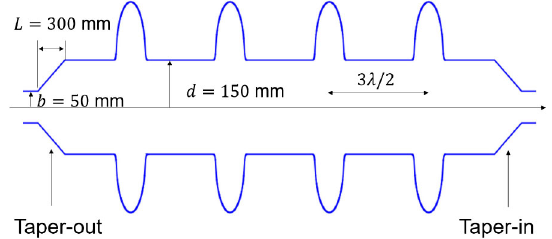
FIG. 3. Example of the LHC-like cryomodule containing four single-cell cavities and tapers [7].